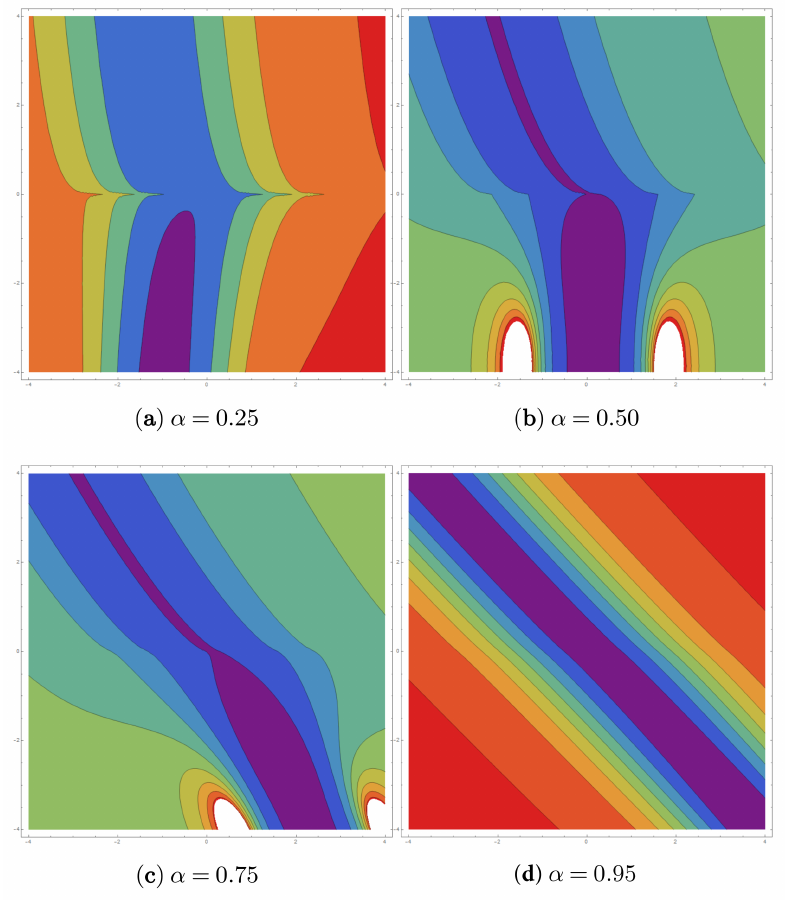
Figure 4. The 2D-contour graphs for S 1